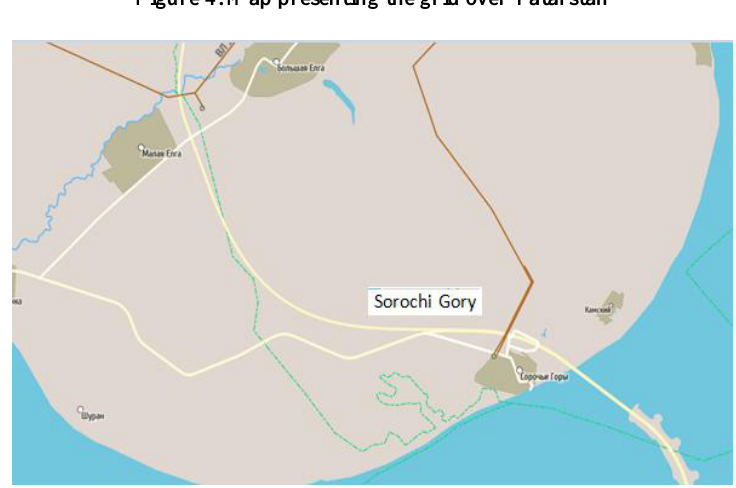
Figure 5. Map presenting the grid over Sorochi